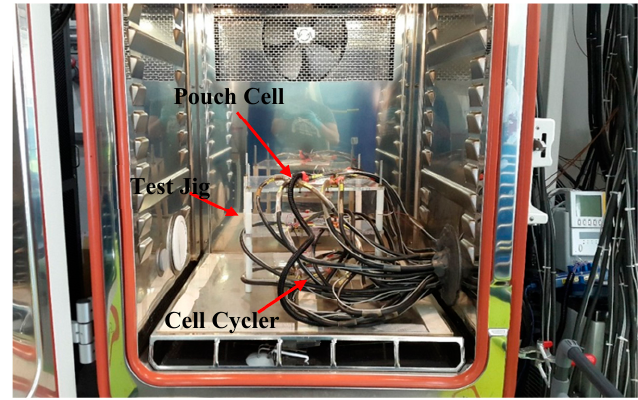
Figure 1. Graphical representation of test setup inside the thermal chamber.